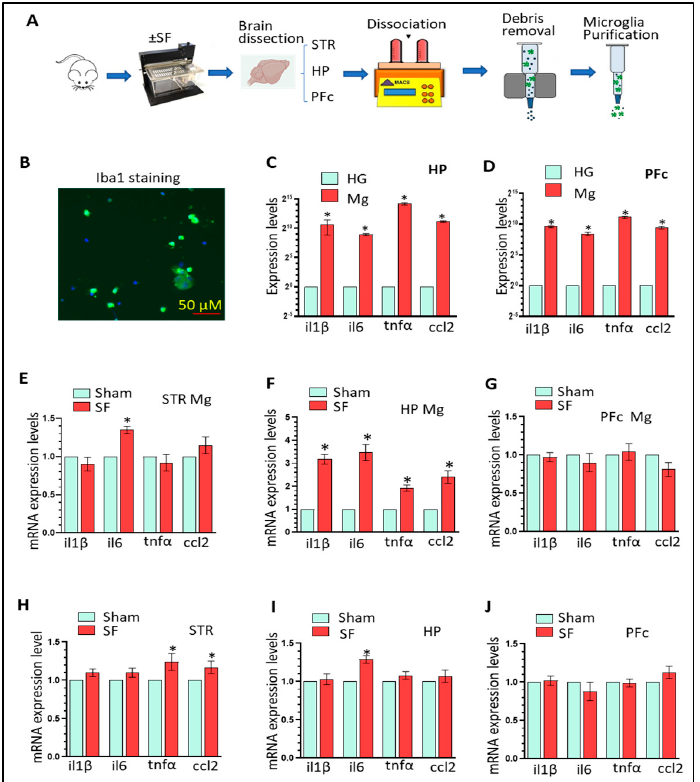
Figure 1. Three-weeks of SF activates microglia in the HP. ( A ): Schematic for the experimental design. ( B ): Iba1 immunostaining for purified adult Mg. ( C , D ): Significant enrichment of pro-inflammatory mediators in purified Mg compared to homogenates from the HP and PFc (n = 6, * p < 0.05). ( E – G ): levels of four pro-inflammatory mediators in purified Mg isolated from the striatum, HP, and PFc of SF and sham mice. (n = 6, * p < 0.05, sham vs. SF). ( H – J ): levels of four pro-inflammatory mediators in the homogenates 6, * p < 0.05, sham vs. SF).